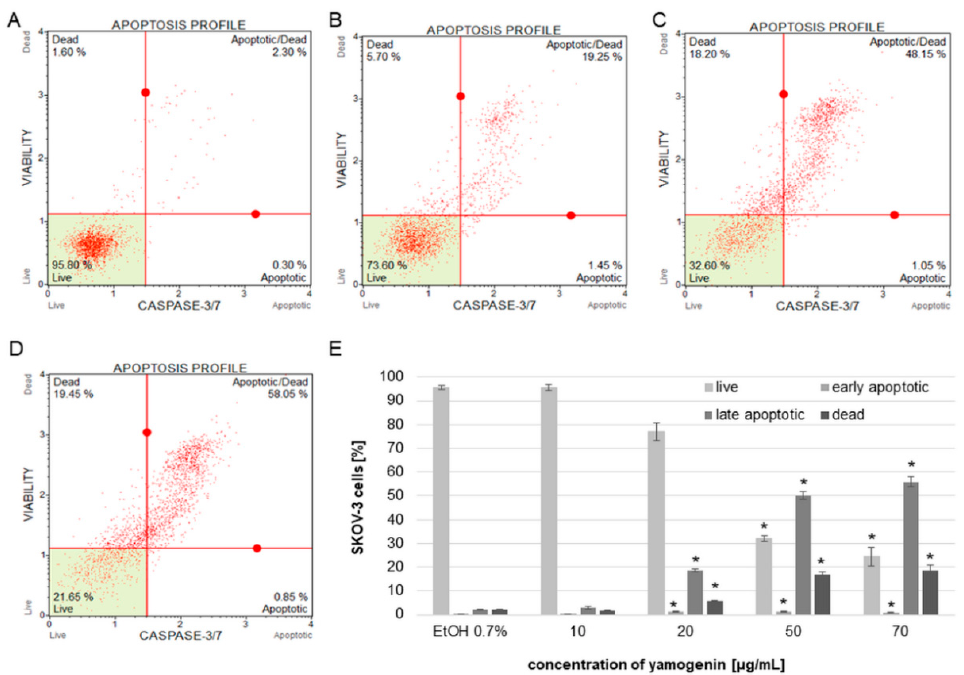
Figure 9. The relative activity level of caspase-8 and -9 in SKOV-3 cells treated with yamogenin. The compound and ethanol were added to the cells at concentrations of 10–70 µg/mL and 0.7% ( v / v ), respectively, for 24 h. The results were obtained with luminometry, and the values represent the means ± SD obtained from three independent experiments. Error bars represent standard deviations. Significant differences relative to the control are marked with an asterisk (the Student’s t -test, * p < 0.05).